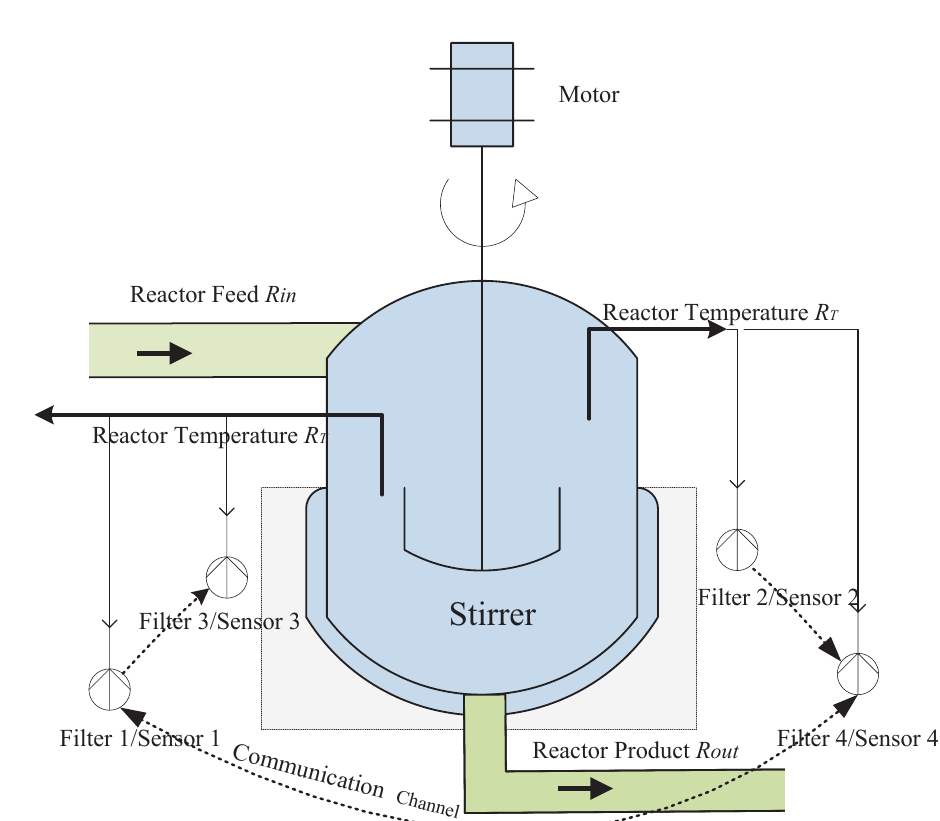
Figure 6. A continuous stirred tank reactor with four sensor